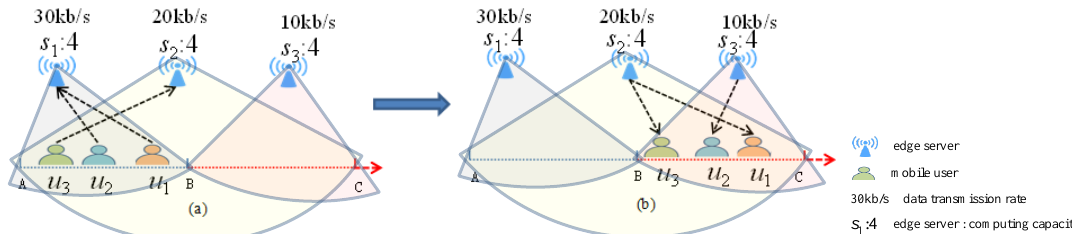
Figure 1. The example of multi-user edge server selection with a single service in mobile edge computing (MEC).